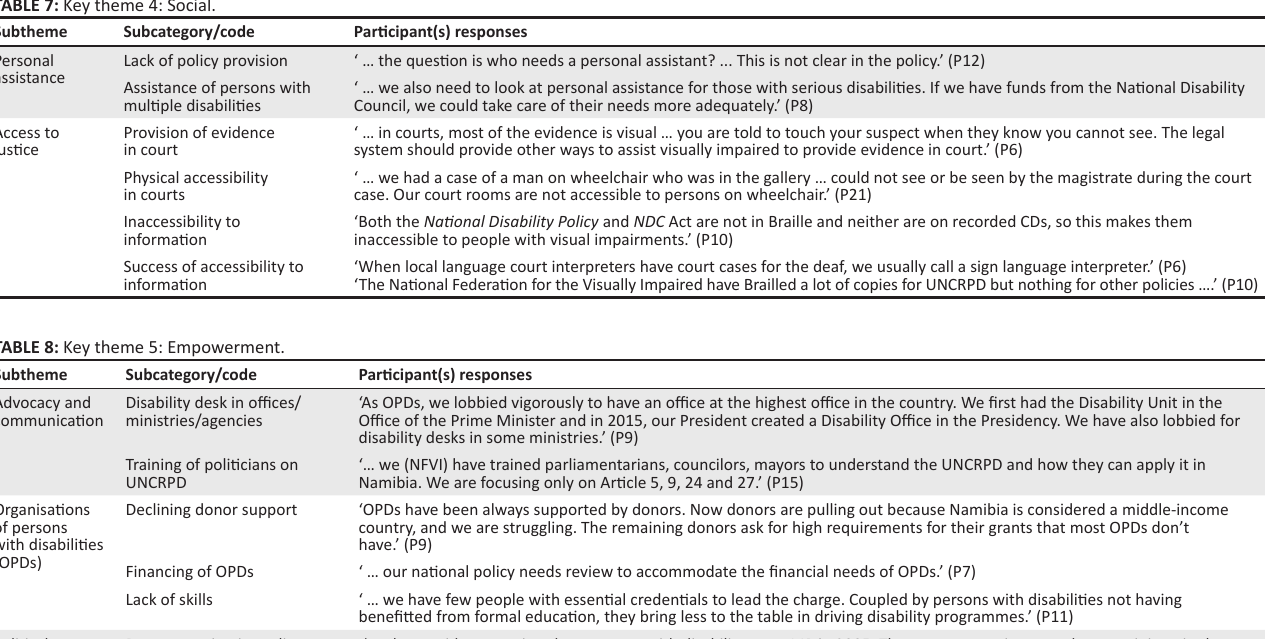
TABLE 7: Key theme 4: Social. Subtheme Subcategory/code Participant(s) responses